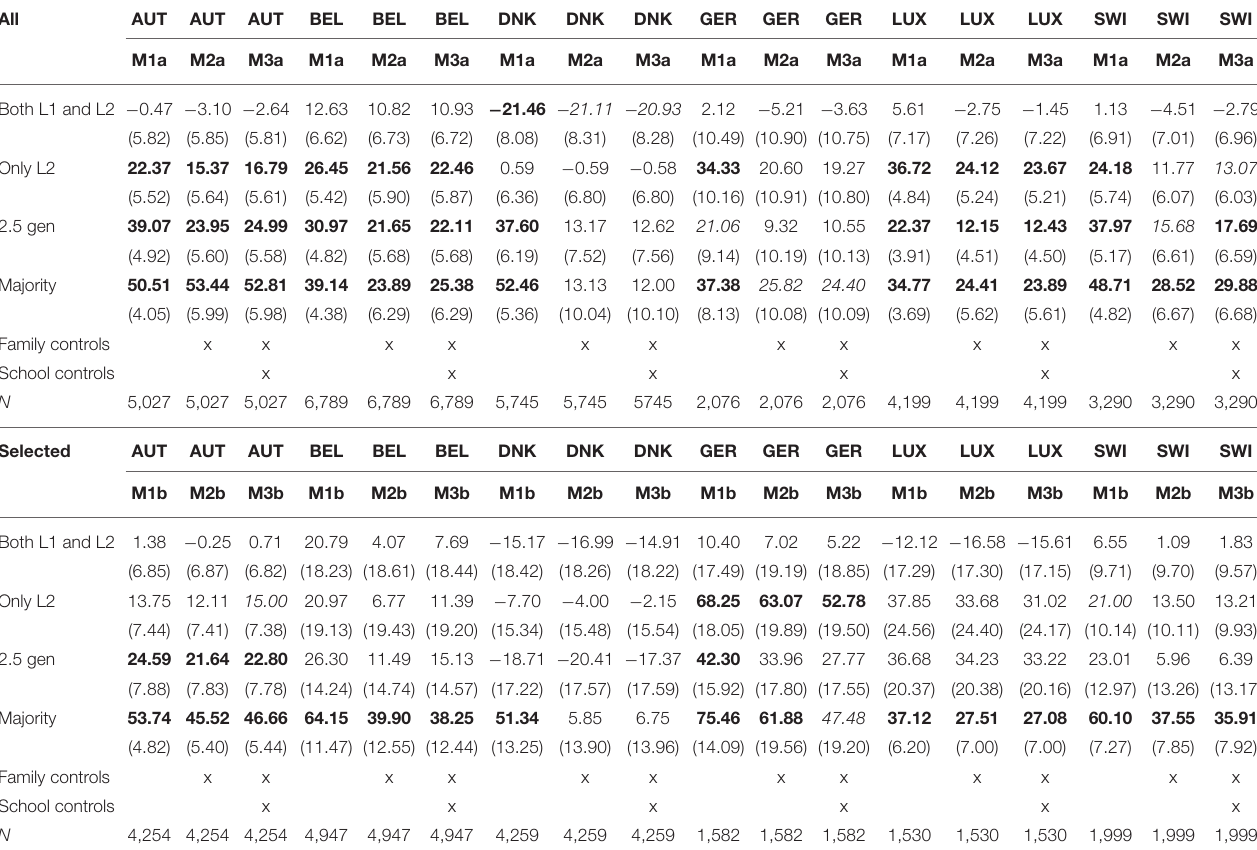
Multilevel linear models with ten plausible values; reference category: speaking mainly L1; all models control for gender, grade, and language of the school; M2 additionally controls for generation, age at migration, country of origin and parental SES; M3 additionally controls for proportion foreign language migrant origin in school, mean SES in school, perception of co-operation and sense of belonging at both individual and school levels (see Table 7 ); bold p < 0.01, italics p <